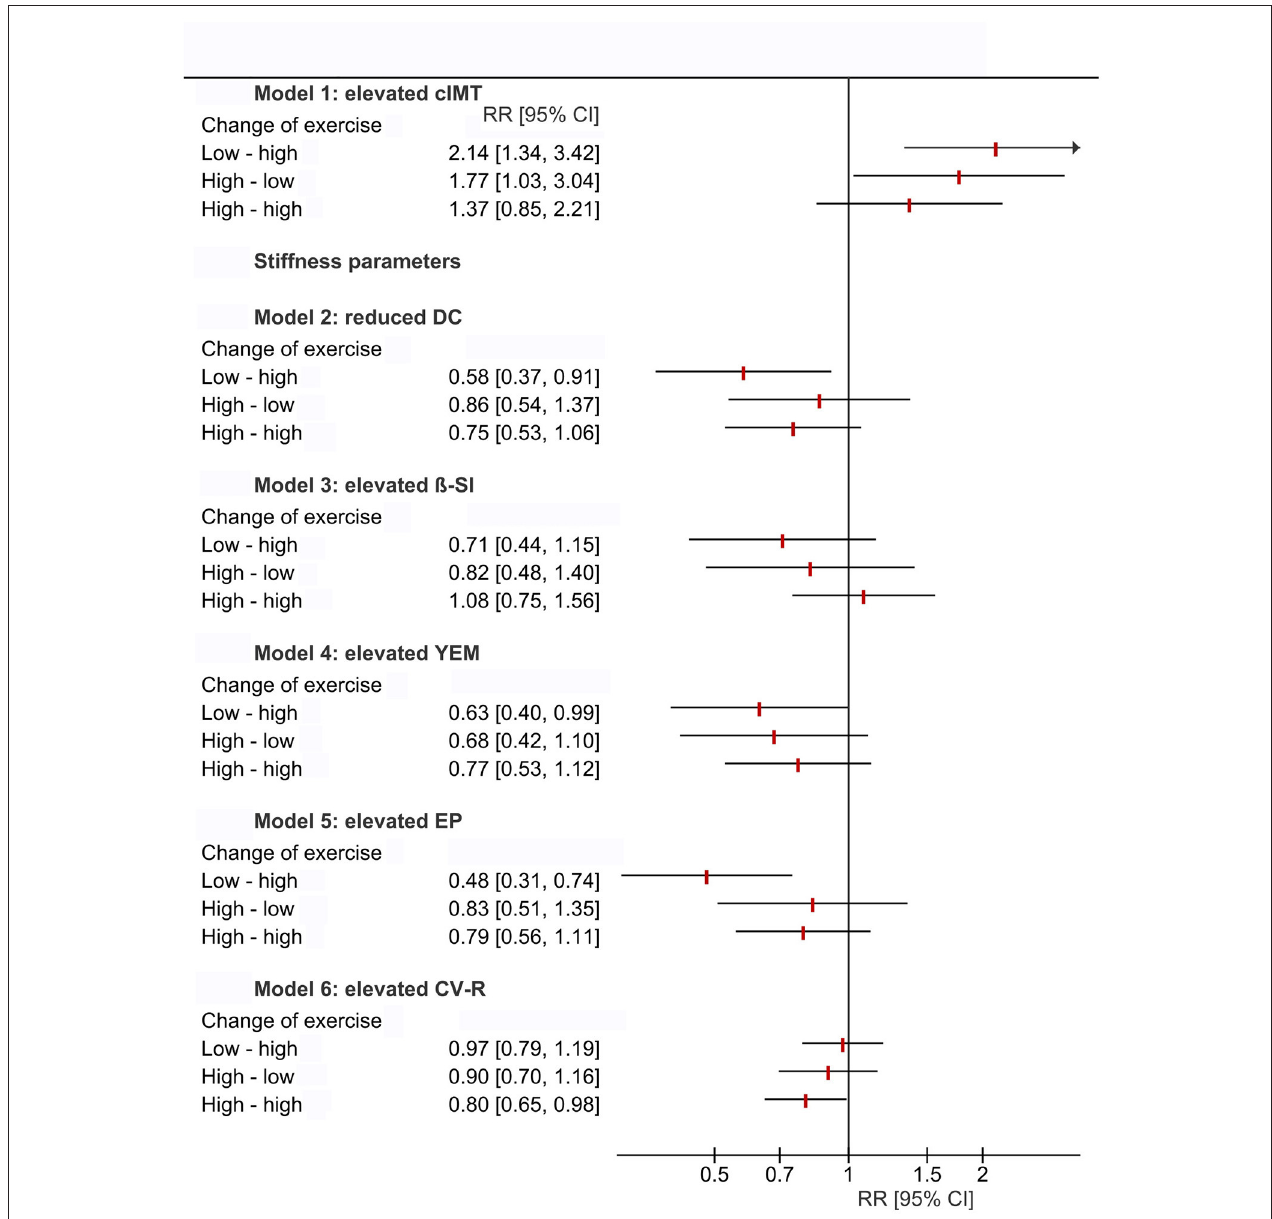
FIGURE 4 | Forest plot demonstrating relative risk for intima-media thickness (cIMT ≥ 90th percentile), parameters of carotid stiffness (cS ≥ 90th percentile) and elevated cardiovascular risk (CV-R ≥ 1 standard deviation) stratified by longitudinal changes of exercise between KiGGS-Wave-1 and KiGGS-Wave-2. Relative risk for elevated CV-R is significantly lower with regularly higher volumes of exercise, as is the relative risk for elevated cS parameters in tendency. No between-group differences were observed for relative risk of elevated cIMT. Results from log binomial regression models. If the 95% confidence interval does not include the null value (RR = 1), the finding is statistically significant. Changes of exercise from KiGGS-Wave-1 to KiGGS-Wave-2: “low-low” (always < 2h), “low-high” ( < 2h at KiGGS-Wave-1 and ≥ 2h at KiGGS-Wave-2), “high-low” ( ≥ 2h at KiGGS-Wave-1 and < 2h at KiGGS-Wave-2), “high-high” (always ≥ 2h); Reference level of exposure: “low-low”; weighted analyses; DC, distensibility coefficient; β -SI, ß stiffness index; YEM, Young’s elastic modulus; EP, Peterson’s elastic modulus; CV-R, Index of cardiovascular risk (sum of z -scores of mean arterial pressure, triglycerides, total/HDL-cholesterol-ratio, body mass index and HbA1c); RR [95%-CI], Relative risk [95%–confidence